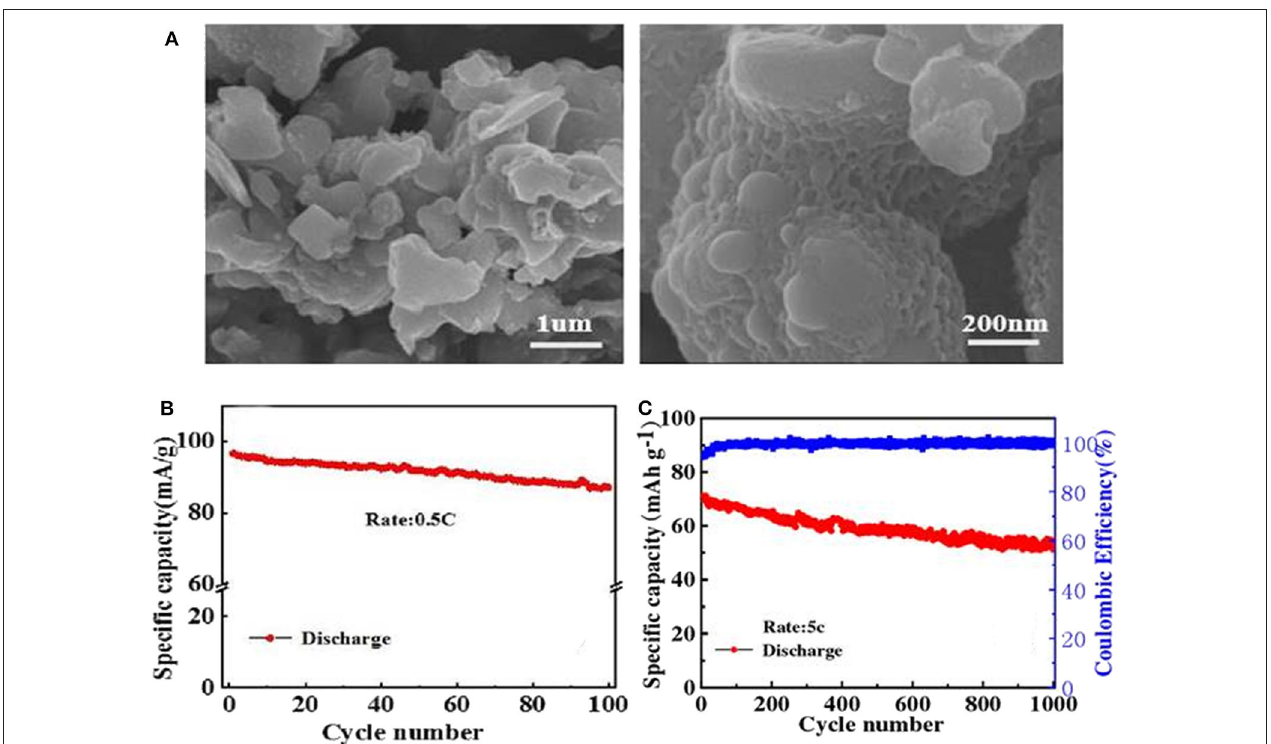
FIGURE 5 | (A) SEM images of NVP/C, (B) cycle performance of the NVP/C, (C) cycle performance of the NVP/C cycled at a rate of 5C for 1,000